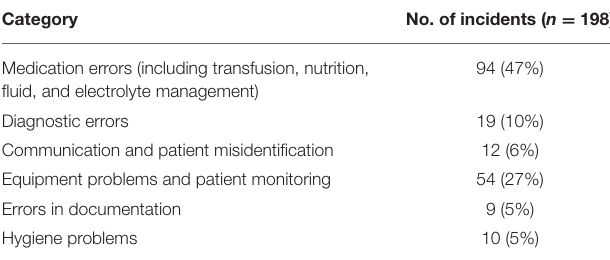
TABLE 1 | Distribution of safety